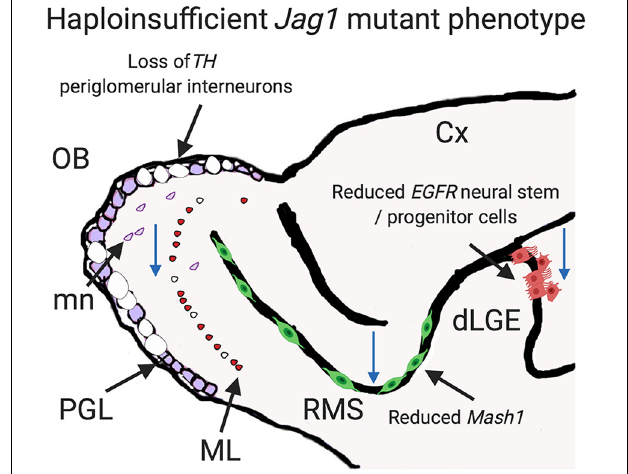
FIGURE 7 | Schematic depicting how haploinsufficient phenotype of Jag1 could disrupt the olfactory system at late embryonic development. Jag1 is essential for the maintenance EGFR + (large red) neural stem/progenitor cells in the dLGE. It is also critical for sustaining Mash1 + progenitors (green) in the RMS. Moreover, Jag1 promotes a proliferative environment in the dLGE, RMS, and OB (blue arrows depict reduced cell division regions). In addition, loss of Jag1 decreases the numbers of TH + and GluR1 + bulbar interneurons in the periglomerular (PGL; blue and empty circles) and mitral layer (ML; small red). TH + migrating neurons (mn; purple) are also reduced. Cx, cortex, dLGE, dorsal lateral ganglionic eminence; OB, olfactory bulb; mn, migrating neurons; PGL, periglomerular layer; ML, mitral layer; RMS, rostral migratory stream; dLGE, dorsal lateral ganglionic eminence; Cx, cortex.